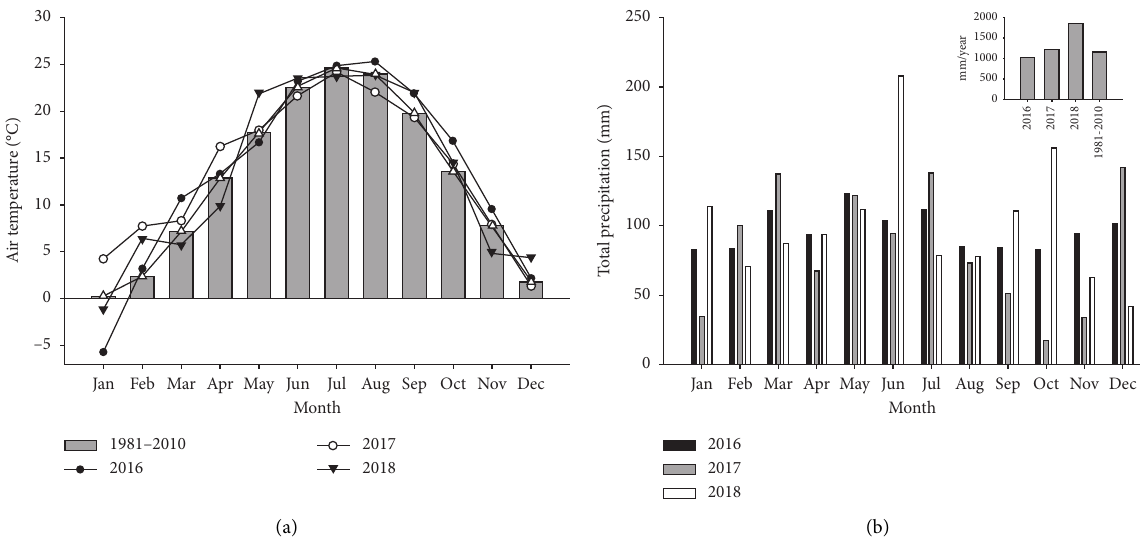
Figure 1: Average air temperature ( ° C) (a) and monthly annualized precipitation (mm) (b) at the Harold R. Benson Research and Demonstration Farm for the observation period of 2016–2018. Precipitation records are from the Franklin County Mesonet Weather Data (Lat: 38:12 ° N; Lon: − 84.88 ° W, which is located about 670m from the flux station. Long-term (normal, gray bars) data are from the National Weather Service Capital City Airport, Station no. US W00053841 (Lat: 38.1847 ° N; Lon: − 84.9033 ° W) (National Oceanic and Atmospheric Administration, National Environmental Satellite Data and Information Service (NOAA/NCDC)) (https://gis.ncdc.noaa.gov/maps/ncei/ normals))